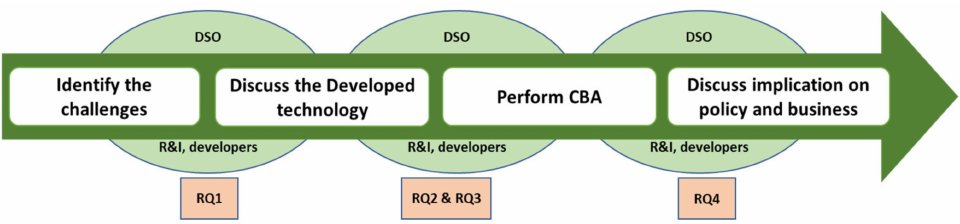
Figure 1. Research framework to answer research questions of the